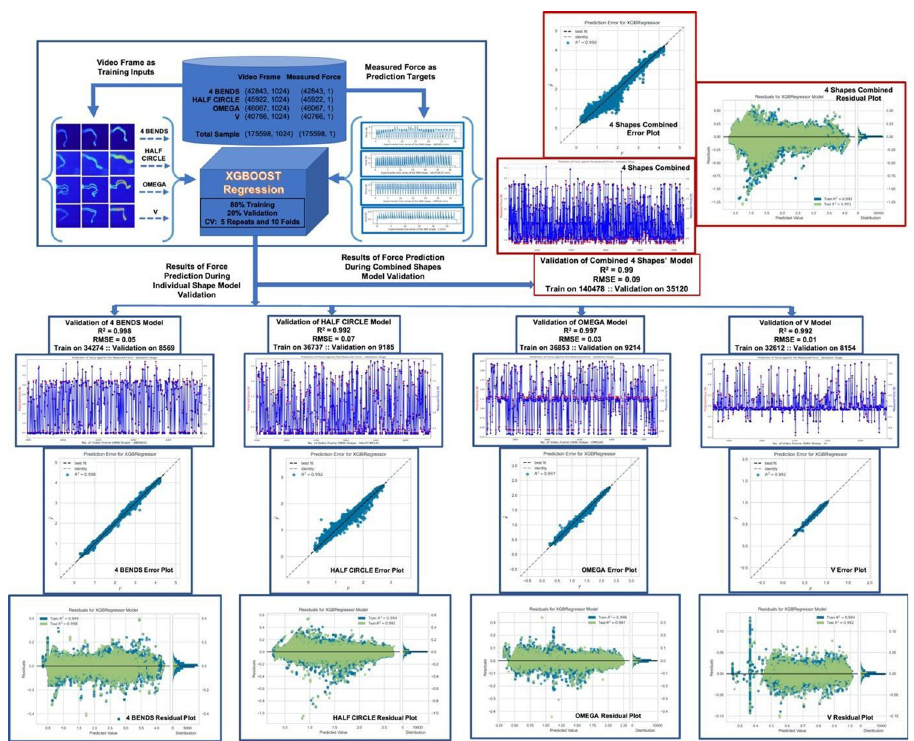
Fig 6. Results of prediction for the aim B. A XGBoost regression model was the best model to predict possible amounts of force with a R 2 score in a range of 0.99–0.998, achieving a mean accuracy of 99.5%. This figure shows the schematic diagram of the infrared video data-based force prediction capability, input and outputs of the model, and the prediction results consists of mean R 2 score, Root Mean Square Error (RMSE), Error plots and Residual plots.